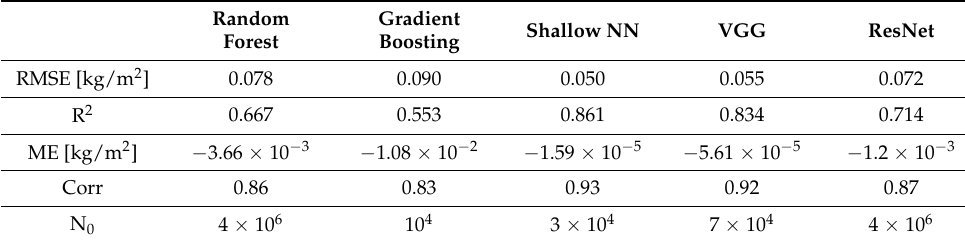
Table 4. SWP estimation